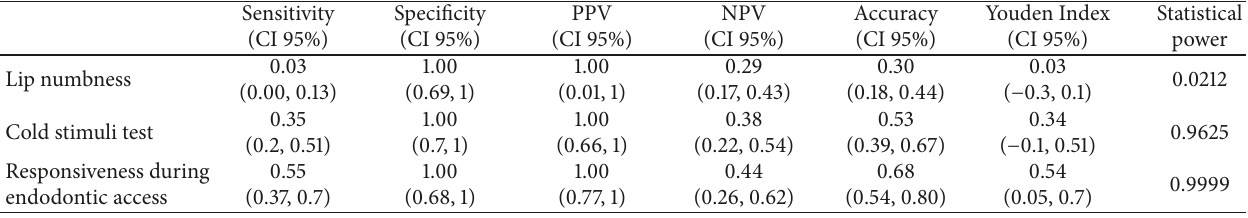
Table 1: Sensitivity, specificity, predictive values (positive (PPV) and negative (NPV)), accuracy, the Youden Index, and the statistical power for the diagnostic tests.